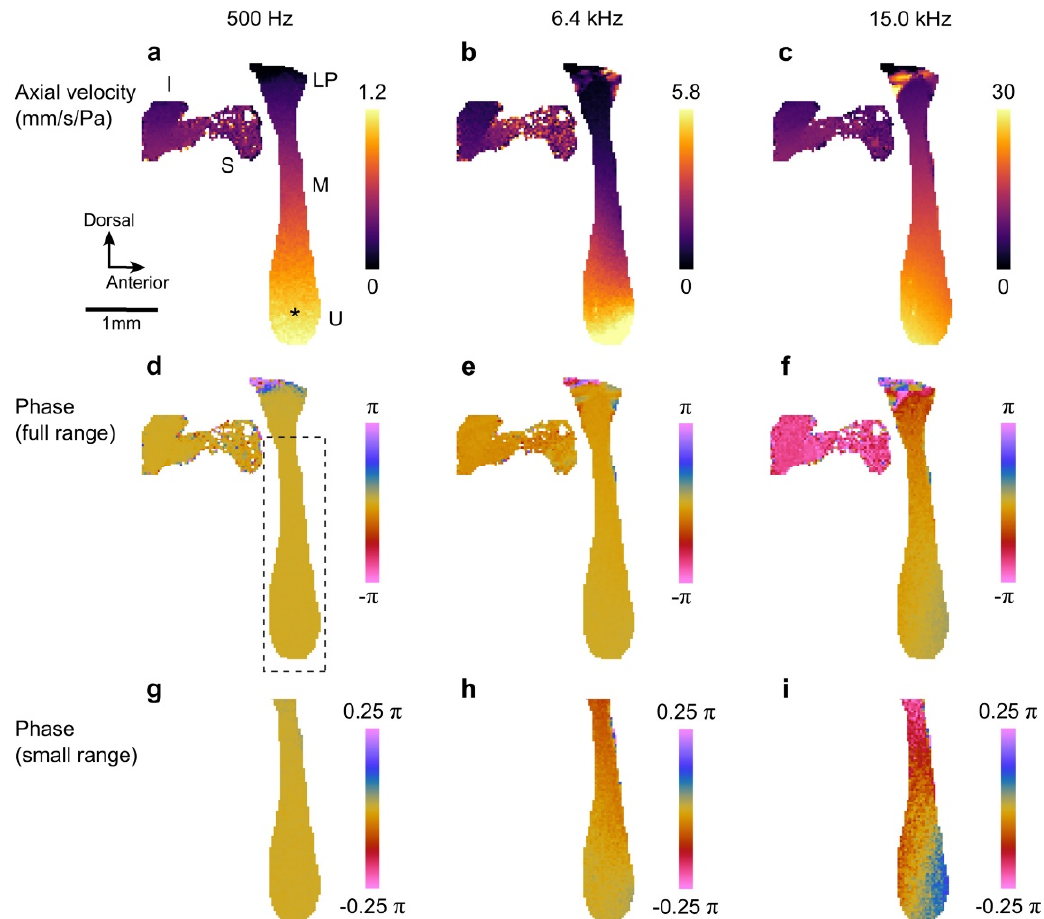
Figure 3. Projection view of the ossicular chain at 500 Hz (100 dB SPL), 6.4 kHz (108 dB SPL), and 15 kHz (103 dB SPL). ( a – c ) Axial velocity maps. ( d – f ) Phase maps relative to the umbo. ( g – i ) Phase maps of the manubrium (dashed box in d) relative to the umbo. The range of the colormap is reduced to help visualize phase gradients along the manubrium. Labels: manubrium (M), incus (I), stapes (S), lateral process (LP), and umbo (U); * shows the umbo location used as phase reference. Reprinted with permission from Ref. [47] . © The Optical Society.